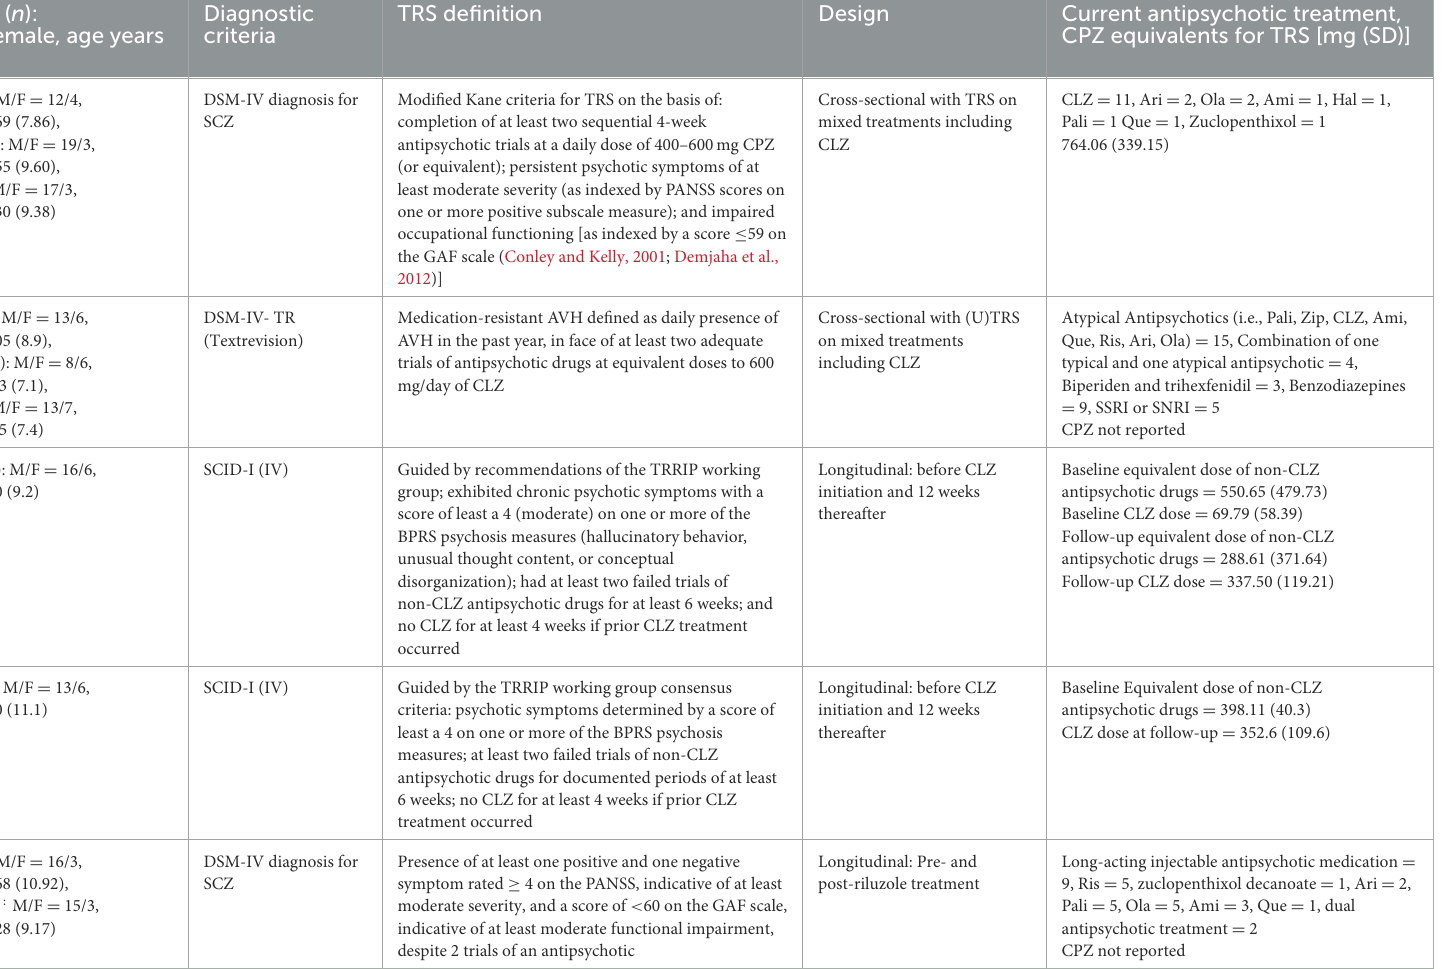
Modified Kane criteria for TRS on the basis of: completion of at least two sequential 4-week antipsychotic trials at a daily dose of 400–600mg CPZ (or equivalent); persistent psychotic symptoms of at least moderate severity (as indexed by PANSS scores on one or more positive subscale measure); and impaired occupational functioning [as indexed by a score ≤ 59 on the GAF scale (Conley and Kelly, 2001; Demjaha et